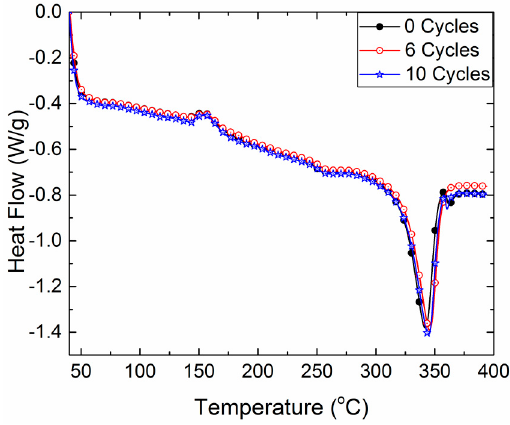
Figure 7. DSC curves between the temperature and heat flow of Roechling PEEK (12 mm) after 0, 6, and 10 autoclave cycles.